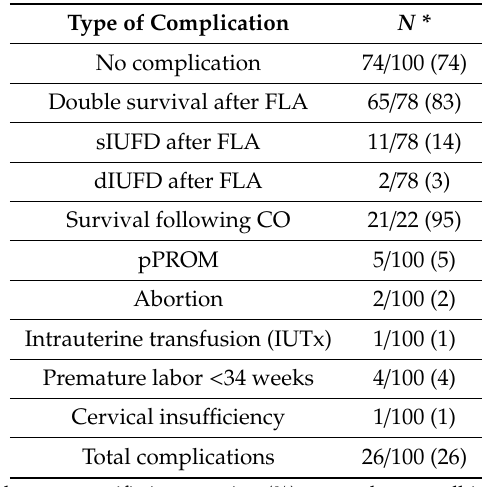
Table 4. Obstetric and fetal complications within 2 weeks after the